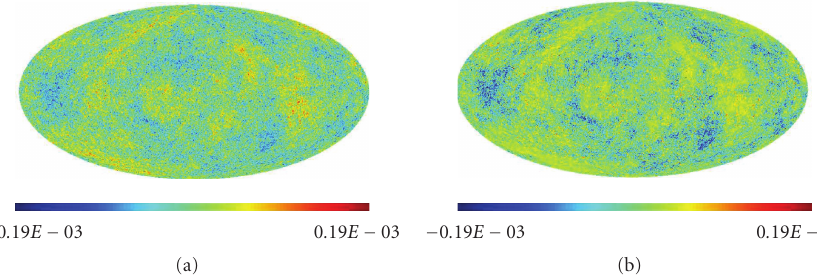
Figure 12: (a), (b) A Gaussian realization of the CMB sky (a) and a non-Gaussian local CMB map (b), obtained by adding to the Gaussian = 3000, from the study by Liguori et al. in [117]. (b) and (d) A Gaussian CMB map (c) and a non- one a NG component with f loc NL = 4000, from [9]. The maps in the upper panel have been obtained using the local algorithm described in Gaussian DBI map (d) with f DBI NL Section 3.10.1. The maps in (b) have been produced with the bispectrum algorithm of Section 3.10.2, after having separated the primordial DBI shape using the eigenmode expansion defined in